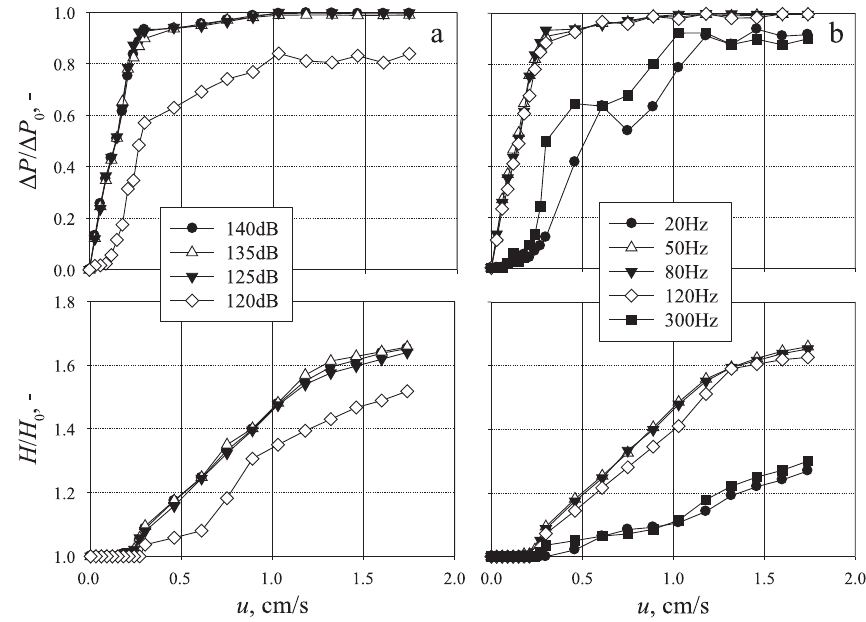
Fig. 13 (a) Effect of SPL on pressure drops and bed expansion curves at fixed frequency (80 Hz); (b) effect of frequency on pressure drops (c) and bed expansion curves at fixed SPL (140 dB).